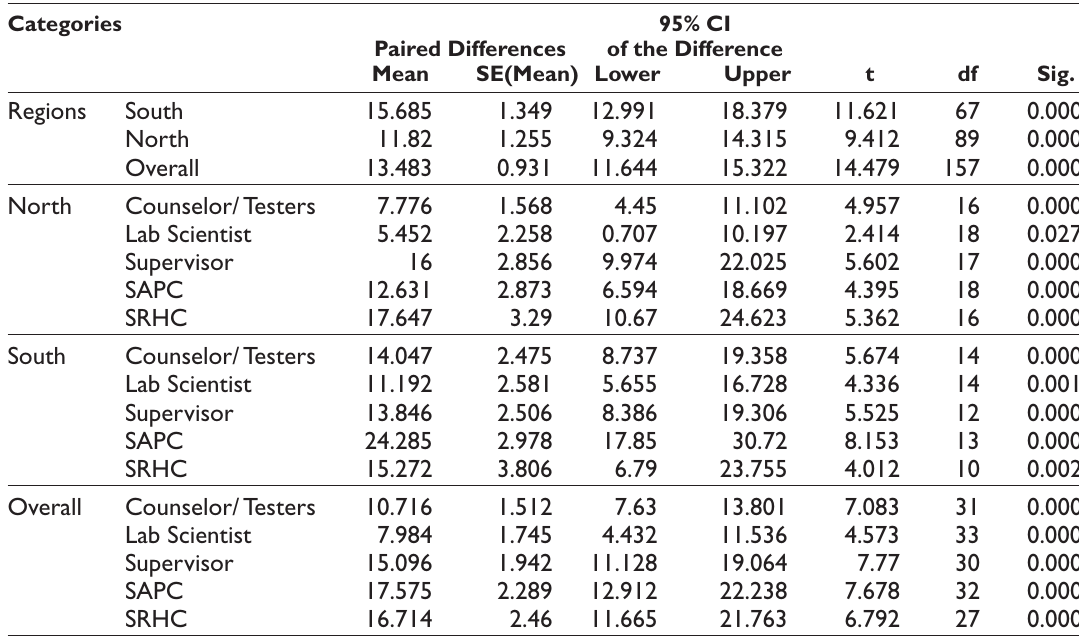
Analysis of Knowledge Gained (differences between the paired Posttest and Pretest scores) by the attendees